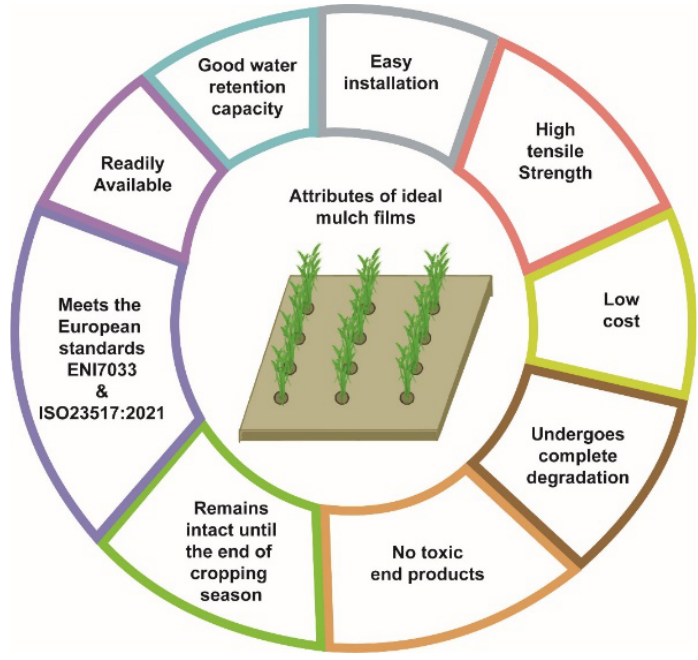
Figure 6. Properties of the ideal mulch film